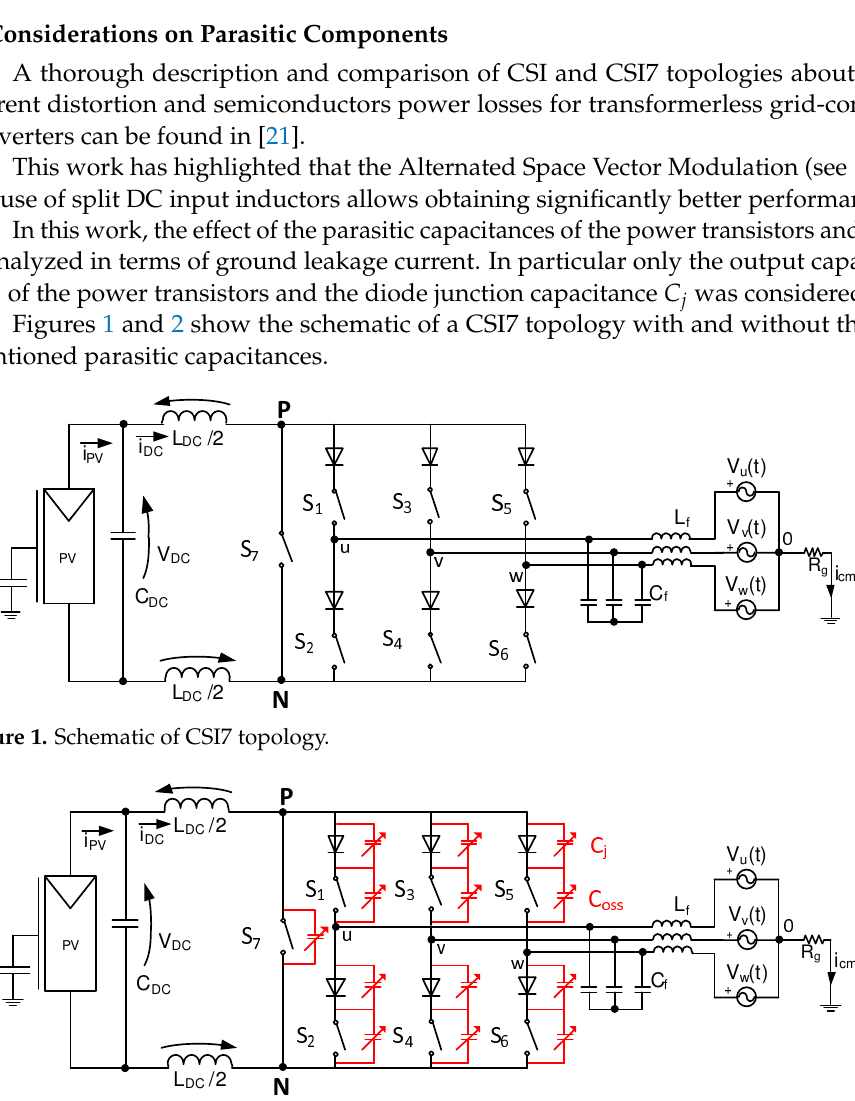
Figure 2. CSI7 topology with parasitic